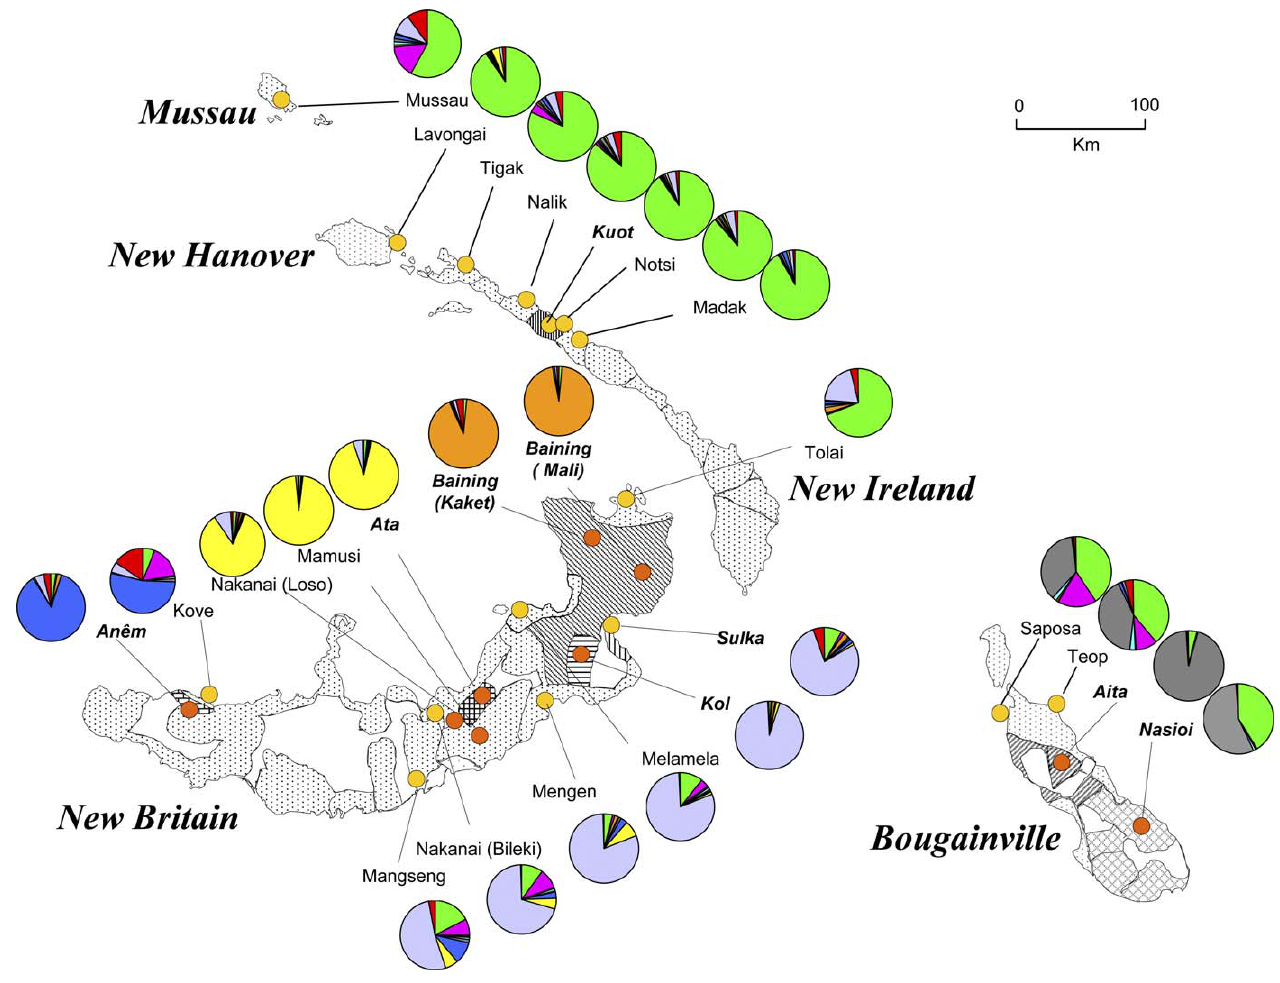
Figure 8. The Geographic Patterning of STRUCTURE Results Distribution of cluster assignment percentages (in pie-charts) among Northern Island Melanesian populations for K ¼ 10. Oceanic-speaking regions are stippled; the different Papuan-speaking regions have stripes or grid marks. Papuan-speaking group names are in bold italics. Inland group locations are dark orange dots; shore group locations are light orange dots. Baining (Mali) and Baining (Kaket) are two dialects; elsewhere, the two Kaket-speaking locales are identified (Rangulit and Malasait), as is Marabu (Mali-speakers).